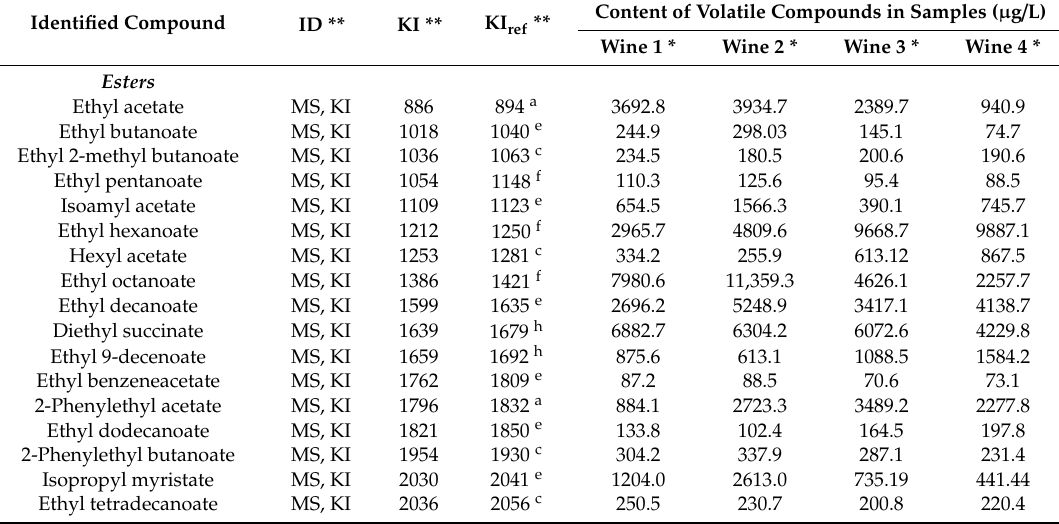
Table 1. Volatile compounds ( µ g / L) identified by solid phase microextraction and gas chromatography / mass spectrometry (SPME GC / MS) technique in wines produced at low temperature using stored (0–90 days) freeze-dried raw materials (grape must and immobilized Saccharomyces cerevisiae AXAZ-1 yeast cells on pine